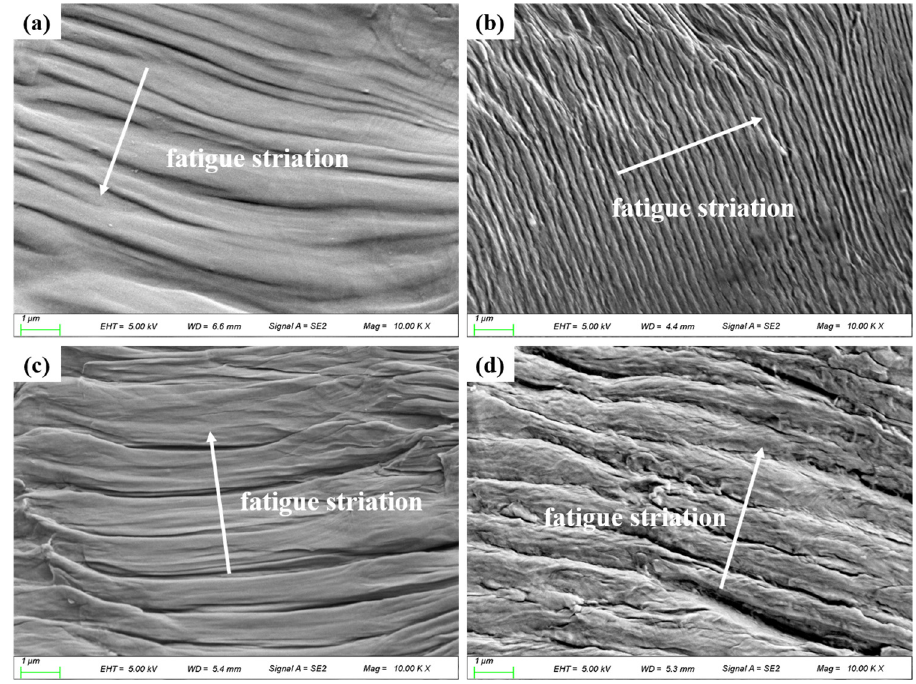
Figure 11. Fatigue striation of the specimens in crack growth stage under different stress ampli- tudes: ( a ) as-received under 210 MPa; ( b ) HESPed under 210 MPa; ( c ) as-received under 320 MPa; ( d ) HESPed under 320 MPa.